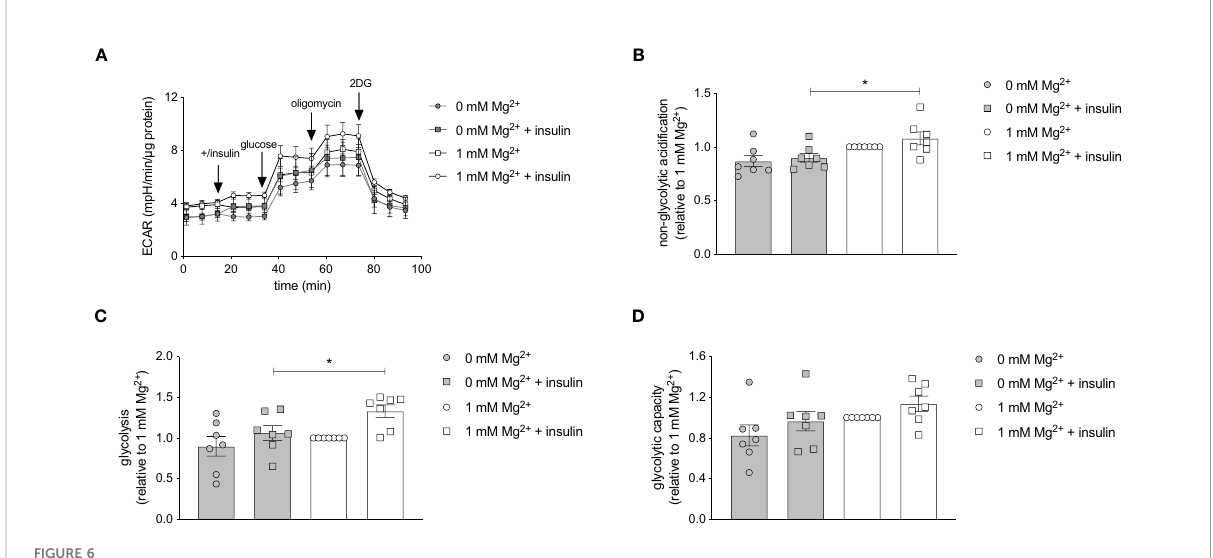
FIGURE 6 Effect of Mg 2+ on insulin-stimulated glycolytic respiration rate in 3T3-L1 adipocytes. Glycolytic Stress Test in insulin-stimulated 3T3-L1 adipocytes incubated with 0 or 1 mmol/L Mg 2+ . (A) Representative raw Glycolytic Stress Test curve in 3T3-L1 adipocytes. Quanti fi cation of the (B) non-glycolytic acidi fi cation, (C) glycolysis and (D) glycolytic capacity in 3T3-L1 adipocytes (n=7). All data adjusted for protein. Legend: circle is without insulin, square is with insulin, grey color is 0 mmol/L Mg 2+ and white color is 1 mmol/L Mg 2+ . Data are shown as mean ± S.E.M. Statistically analyzed with Two-Way ANOVA. *p<0.05. 2DG, 2-deoxyglucose; ECAR, extracellular acidi fi cation rate; Mg 2+ , magnesium; min,